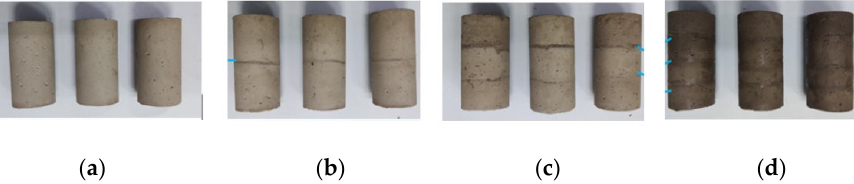
Figure 6. Delamination filling body test block: ( a ) One layer; ( b ) Two layers; ( c ) Three layers; ( d ) Four layers.